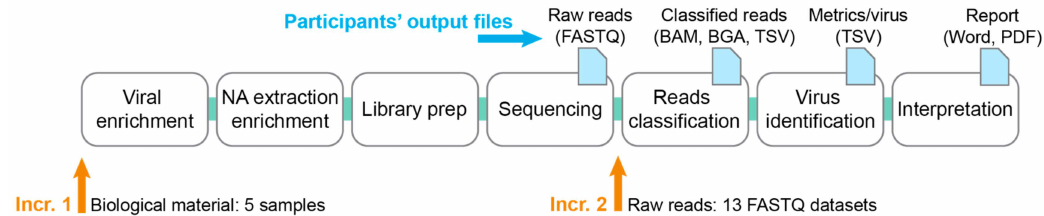
Figure 1. Viral metagenomics ring trial design. The figure shows the complete workflow from the sample to the report, which may include enrichment of viral particles, followed by nucleic acids (NA) extraction and viral nucleic acid enrichment, library preparation, sequencing, classification of reads, summary statistics per virus and final interpretation. For increment 1, five samples consisting of biological material were sent to participants (left orange arrow). For increment 2, participants received 13 FASTQ datasets (right orange arrow). Output files are listed at the top after each workflow step (blue